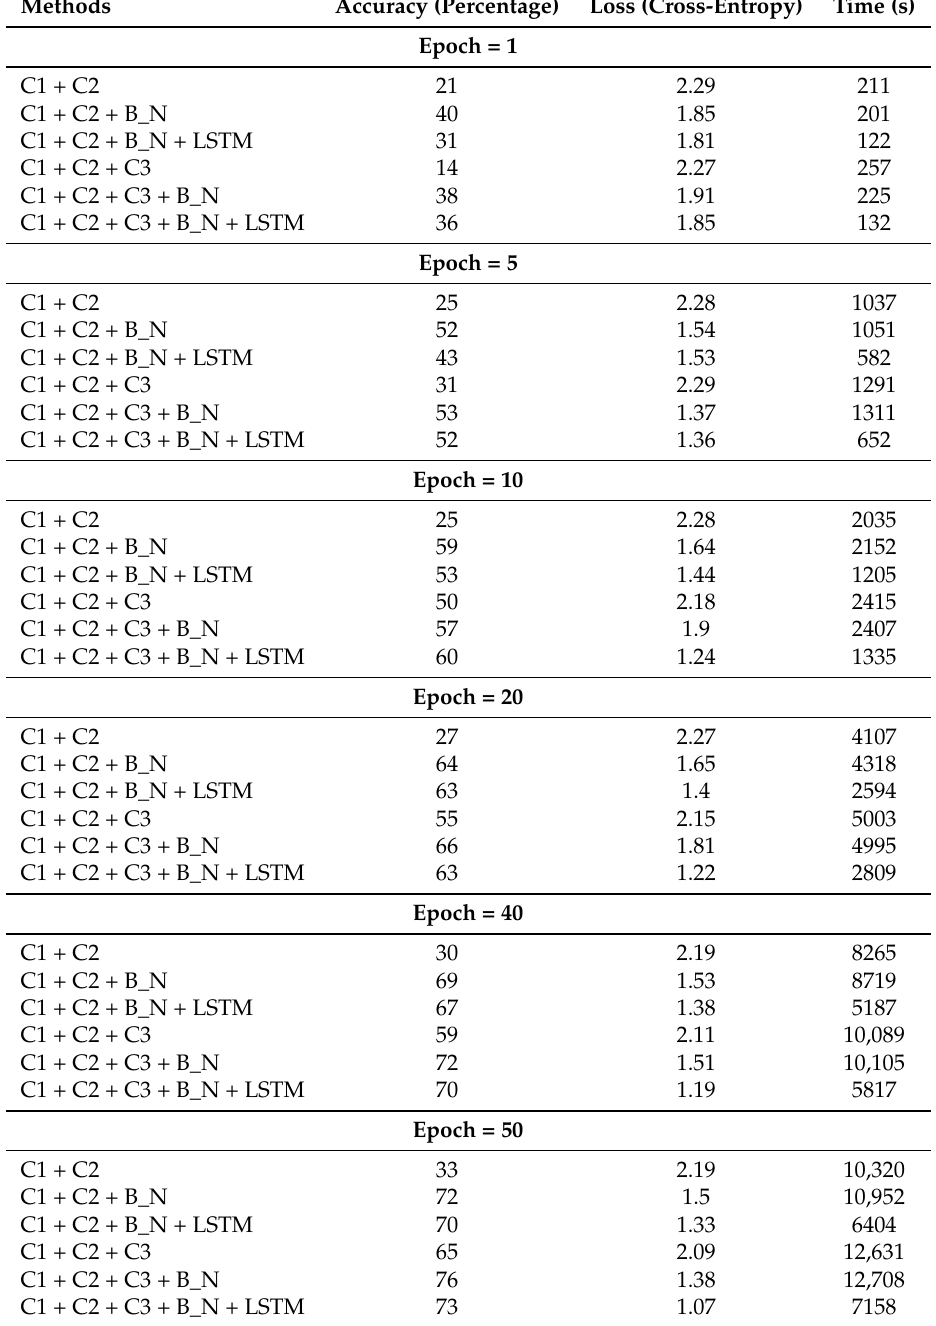
Table 7. Accuracy, loss and time for different numbers of epochs (20% sample) for the CIFAR10 dataset.